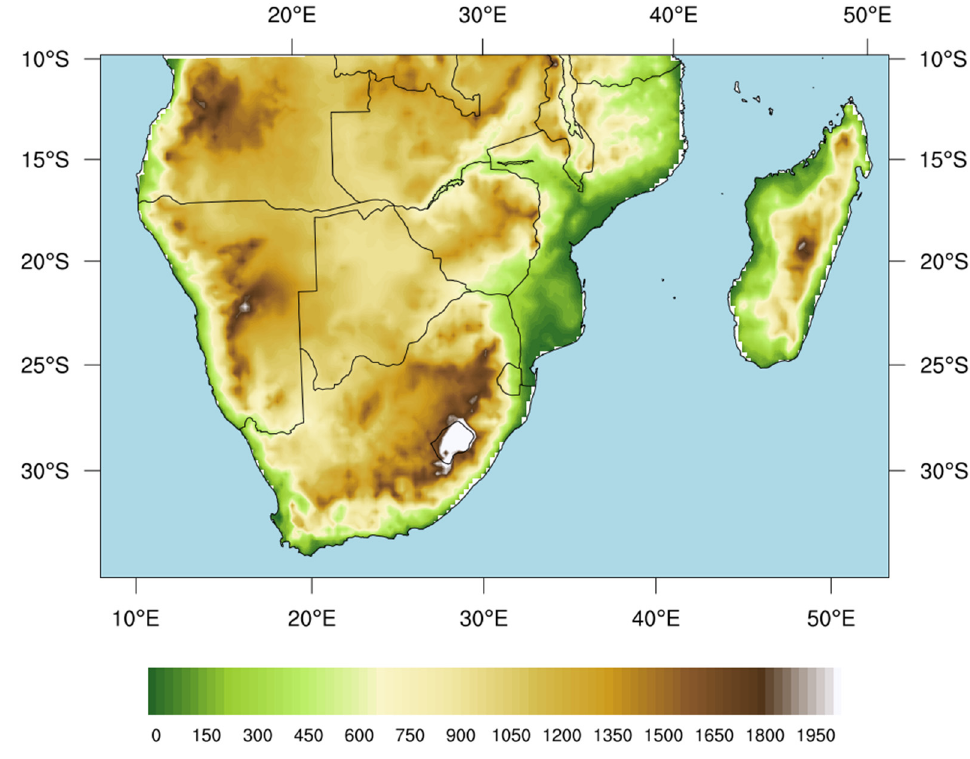
Figure 3. SA region and elevation map (m).